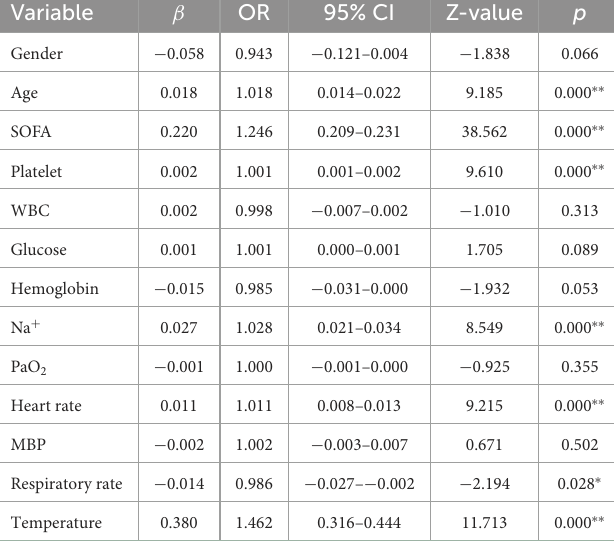
TABLE 2 Logistic regression analysis of risk factors for